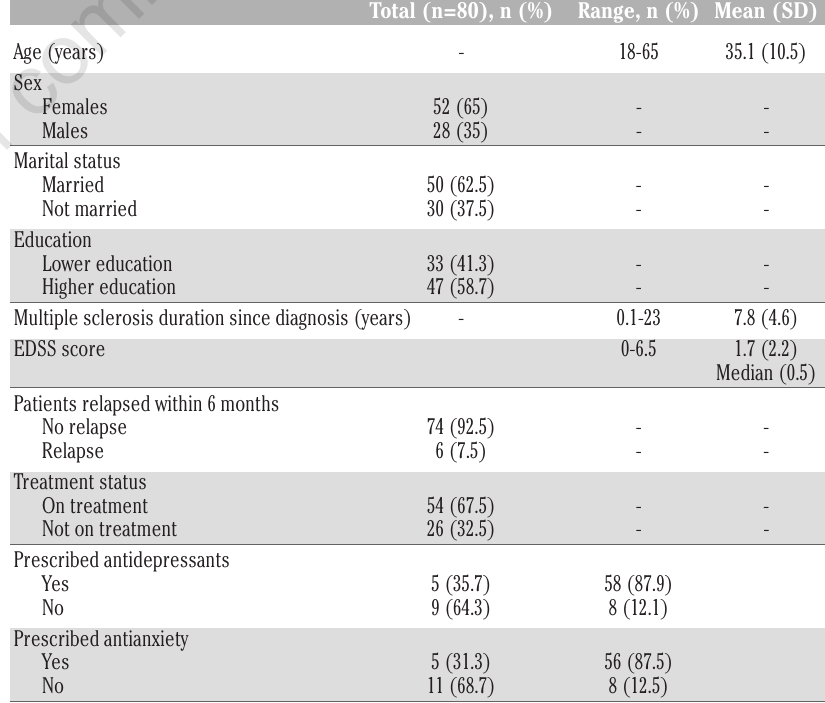
Table 1. Sociodemographic information and disease related